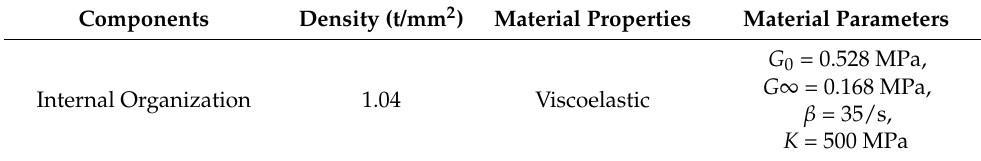
Table 3. Internal tissue material parameters.